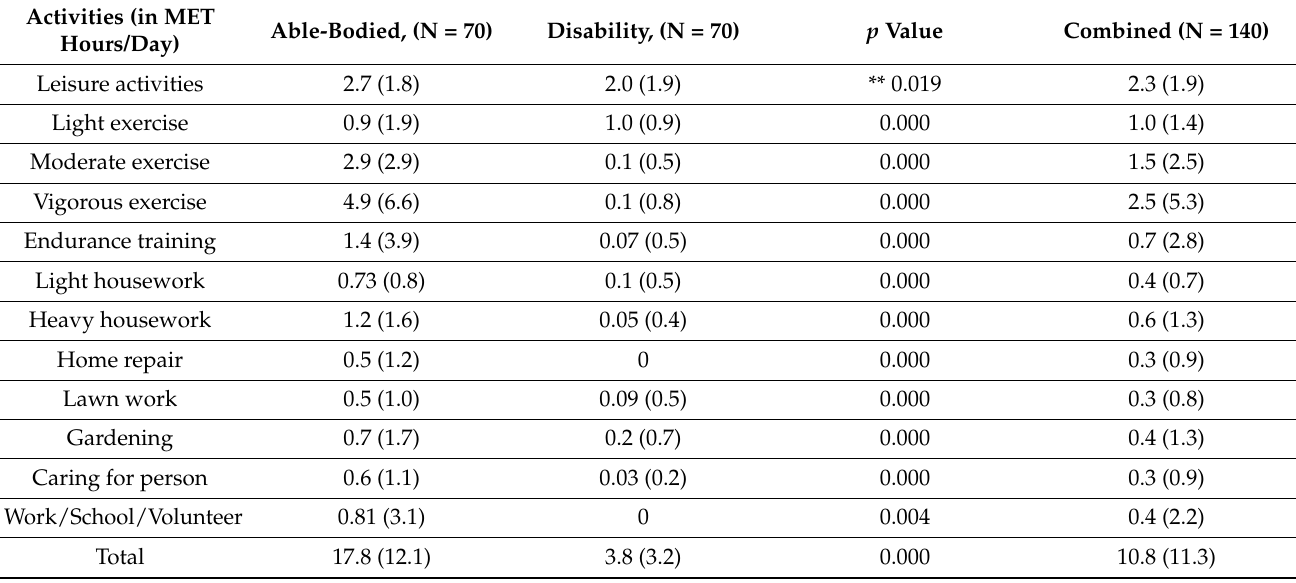
Table 4. Comparison of physical activities performed between children with and without